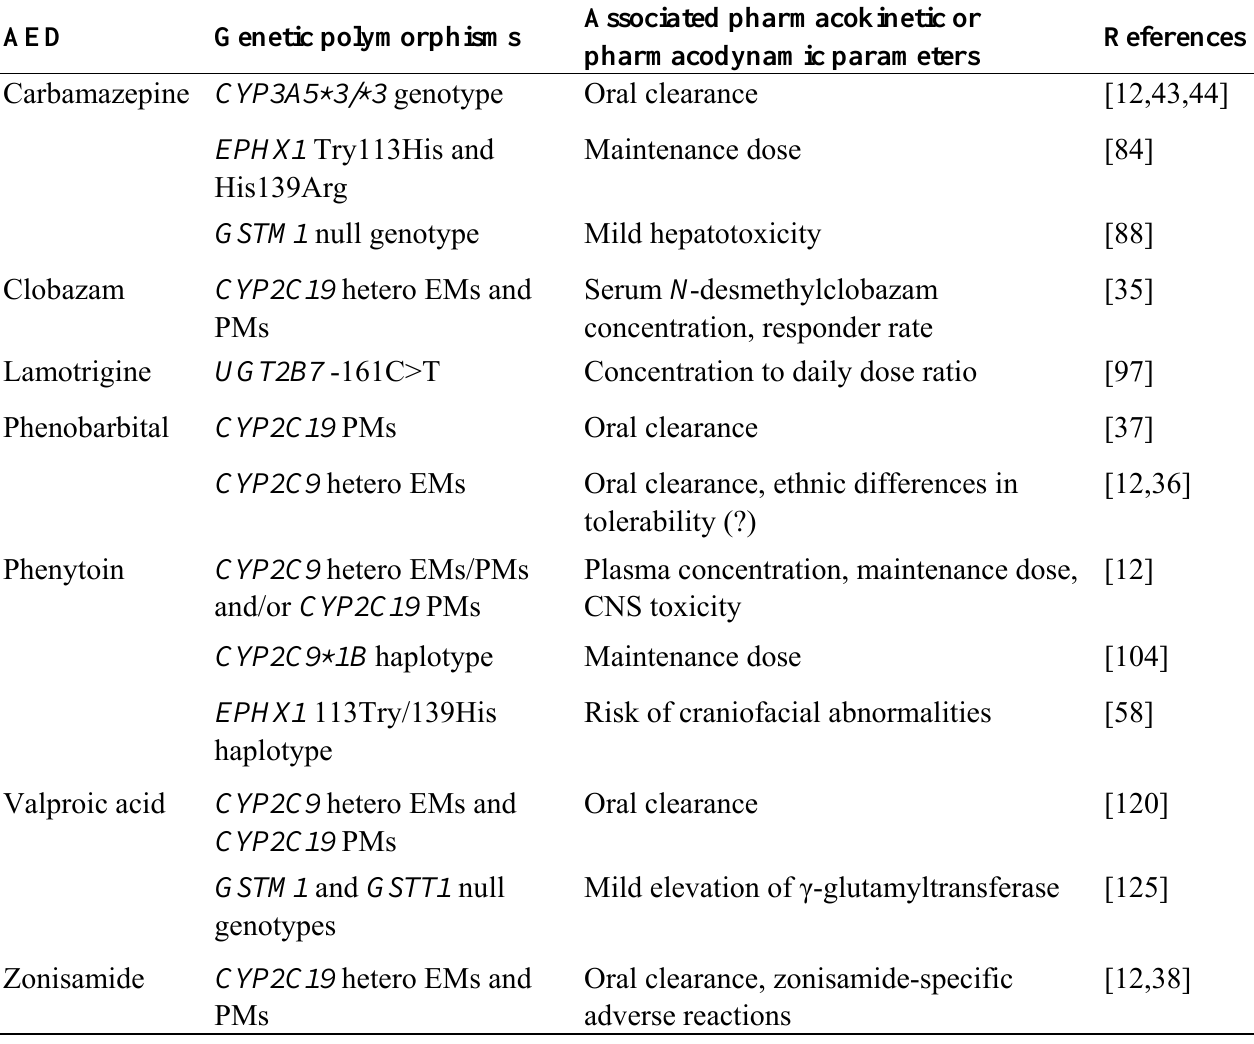
Table 3. The clinical impact of genetic polymorphisms of drug-metabolizing enzymes on AED therapy. Associated pharmacokinetic or AED Genetic polymorphisms pharmacodynamic